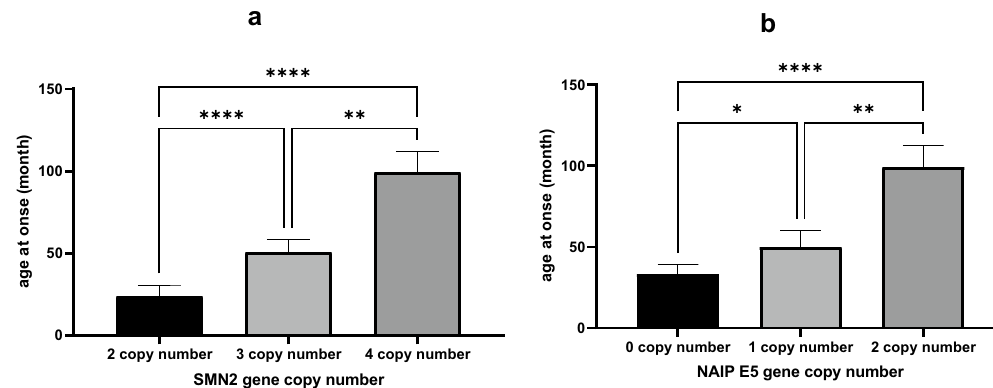
Figure 3. Relationship between copy numbers of exon 7 of SMN2 ( a ) and NAIP ( b ) genes and age at onset of patients. A non-parametric Kruskal–Wallis test was used to identify significant association between the age at onset of patients and SMN2 and NAIP genes copy number (* P value < 0.05, *** P value < 0.001 and **** P value < 0.0001).